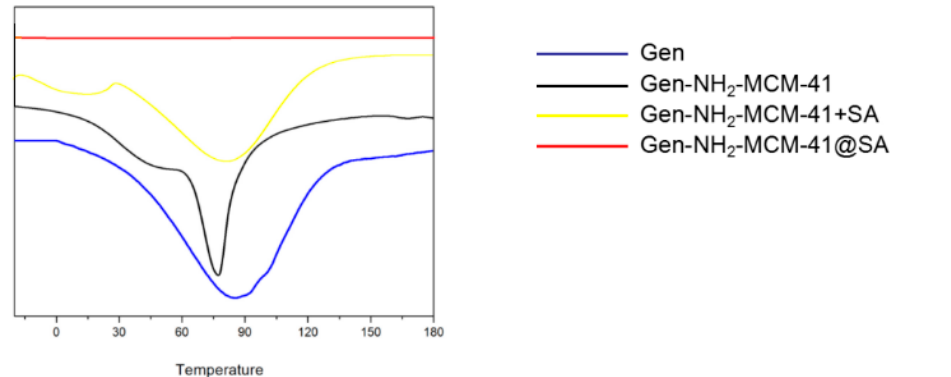
Figure 11. DSC results of Gen, Gen-NH 2 -MCM-41, Gen-NH 2 -MCM-41 + SA physical mixture, and Gen-NH 2 -MCM-41@SA nanoparticles.